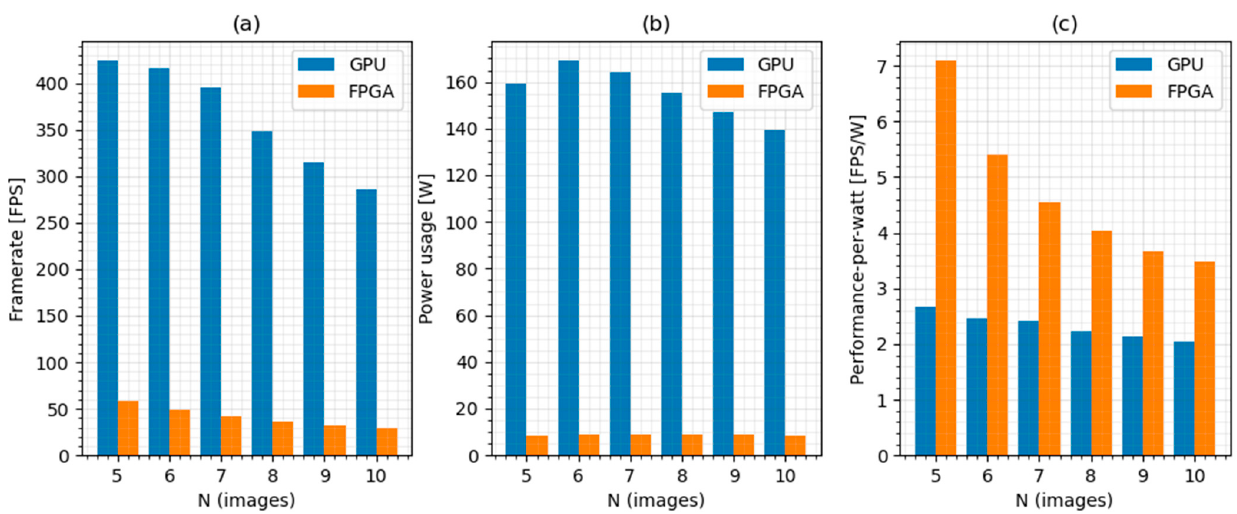
Figure 12. Overview of performance results. ( a ) Average measured framerate for GPU and FPGA. ( b ) Power usage for individual platforms. ( c ) Performance-per-watt for both platforms.